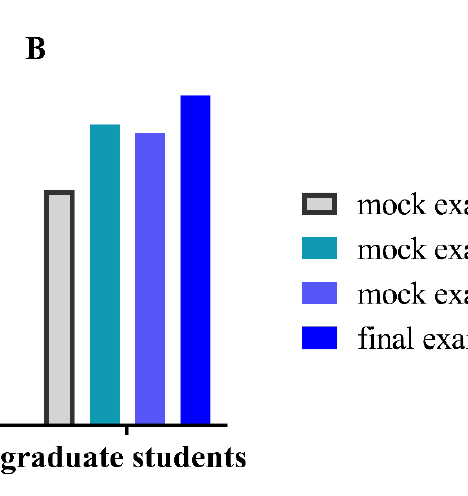
Figure 3. Percent student participation in mock and final exams. Three mock exams were organized for each of the 5 levels in the undergraduate program (A) and the 3 graduate programs (High Diploma, Master, PhD), (B). Mock exams were